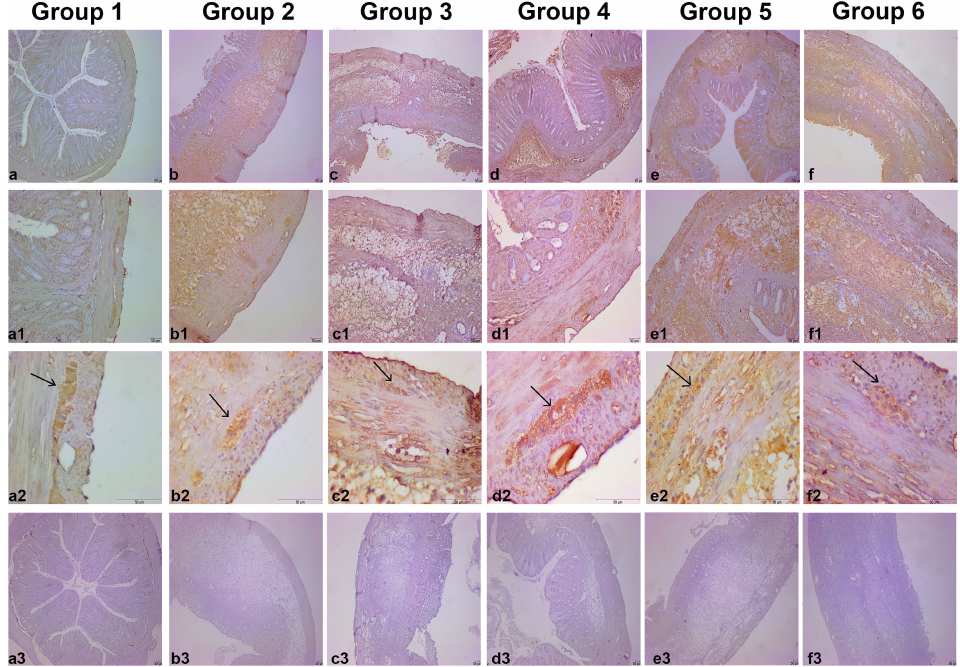
Figure 4. PGP 9.5 immunohistochemistry in colon descendens of experimental groups. Scale bars: 50 µm. (a-f) 40 × , (a1-f1) 100 × , (a2-f2) 400 × magnification. (a3-f3) 40 × magnification and show isotype controls. Black arrows show Schwann cells.